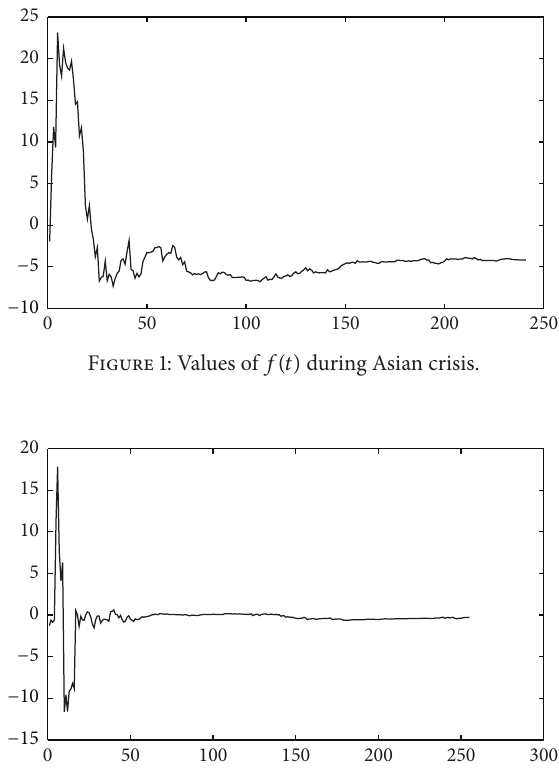
Figure 2: Values of 𝑓(𝑡) during “9/11”